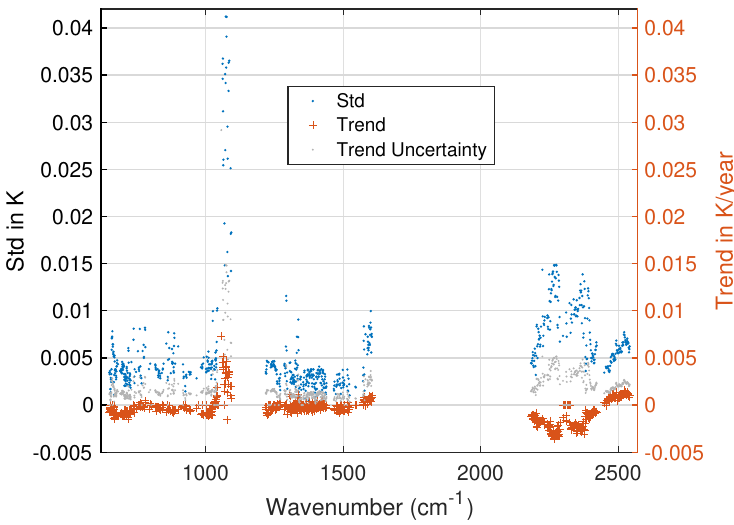
Figure 10. Measures of variability in the CHIRP-AQ minus CHIRP-SN calibration bias (as shown in Figure 8) derived from five yearly averages of the bias ( ∼ 2015–2020). Blue is the standard deviation of the calibration bias over the five years. The linear trend in these biases, again over five years, is plotted in red, and the 2- σ uncertainty in that trend is plotted in gray. Note that these metrics of variability in the instrument calibration biases are very small compared to uncertainties in the inter-instrument bias corrections of ∼ 0.03 K as discussed in the